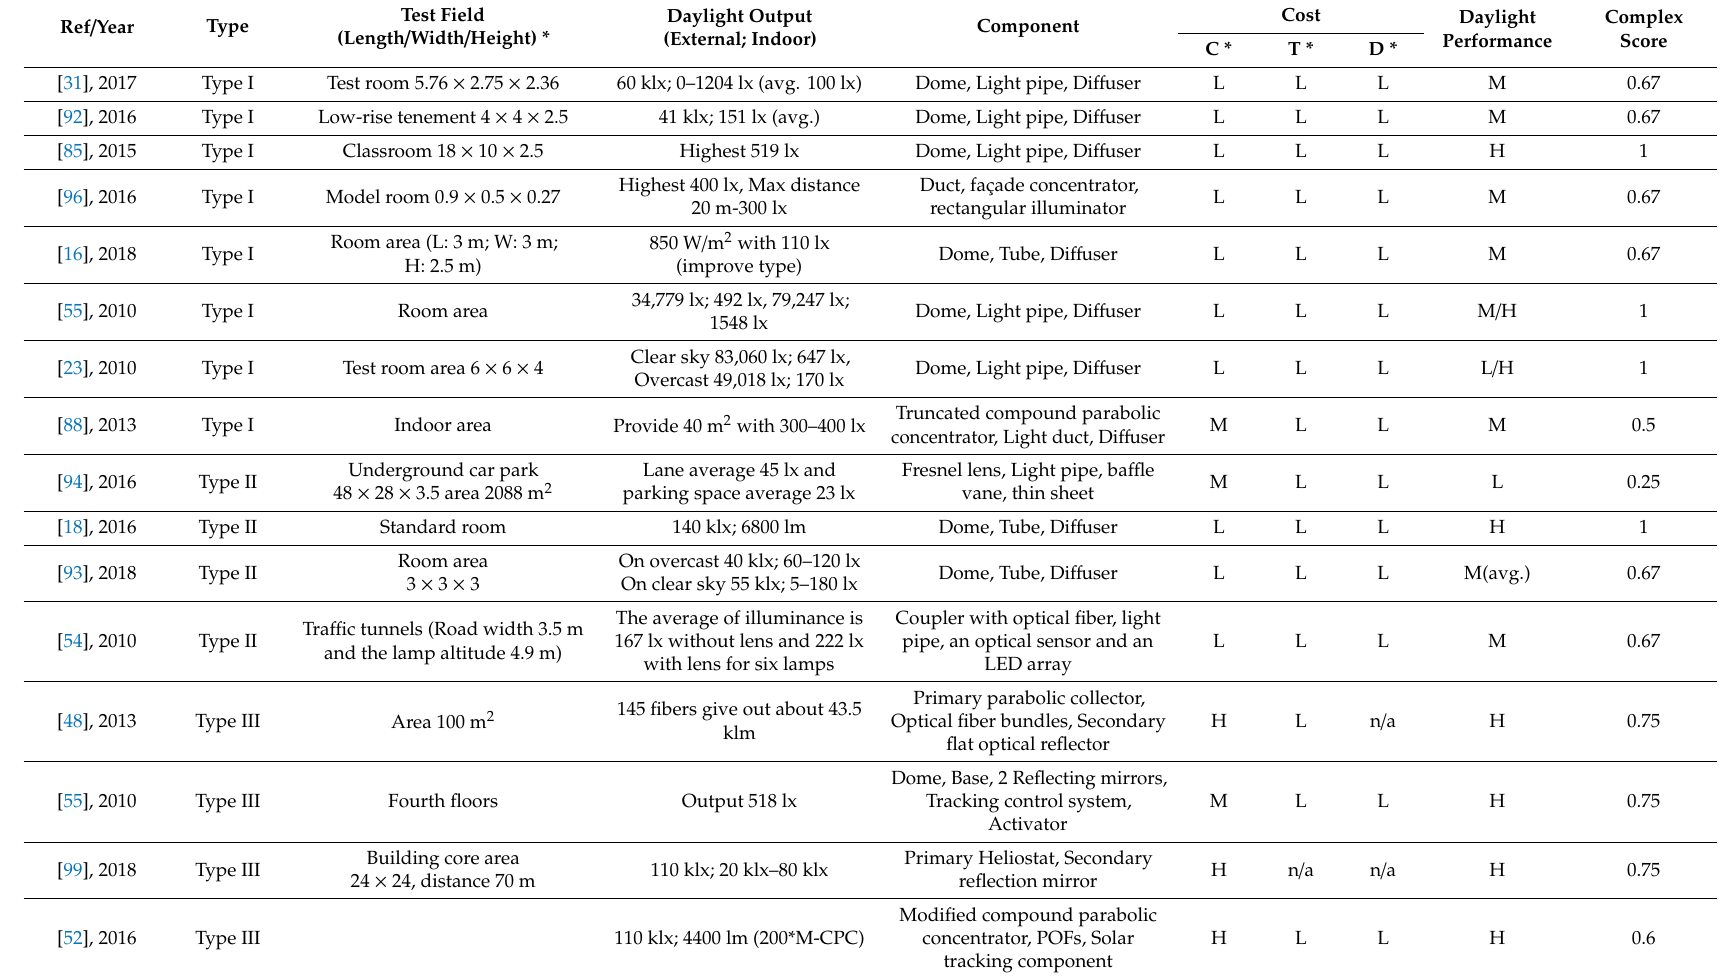
Table 7. Type I to IV system performance, components, cost consolidation and